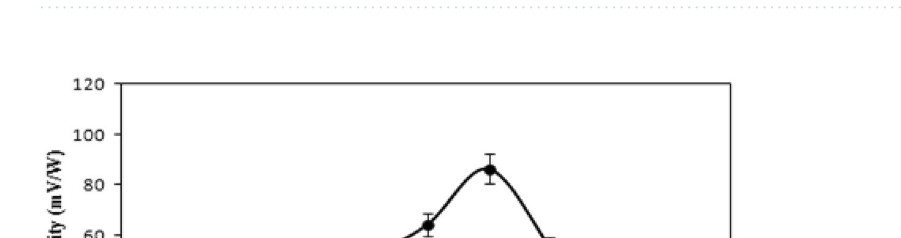
Table 3. Linear response of different thicknesses Sb detectors to Nd: YAG laser.